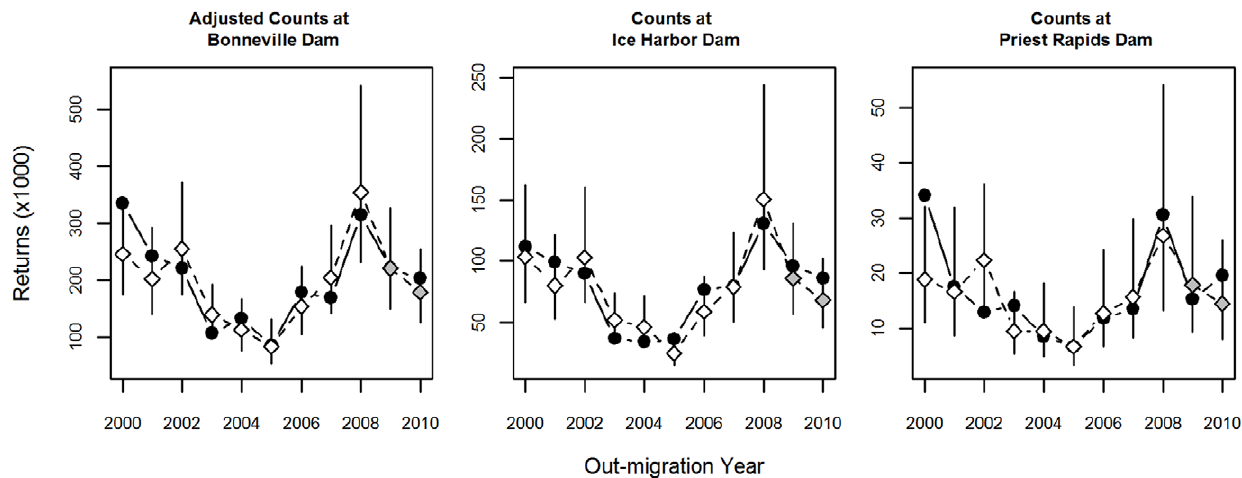
Figure 4. Observed and predicted spring Chinook adult returns. Observed spring Chinook adult returns (solid circles) and leave-one-out predictions (open diamonds) with 95% prediction intervals obtained from MCA. Predicted returns in 2011 and 2012 (2009 and 2010 juvenile migration year) are shown with 95% prediction intervals (grey diamonds).